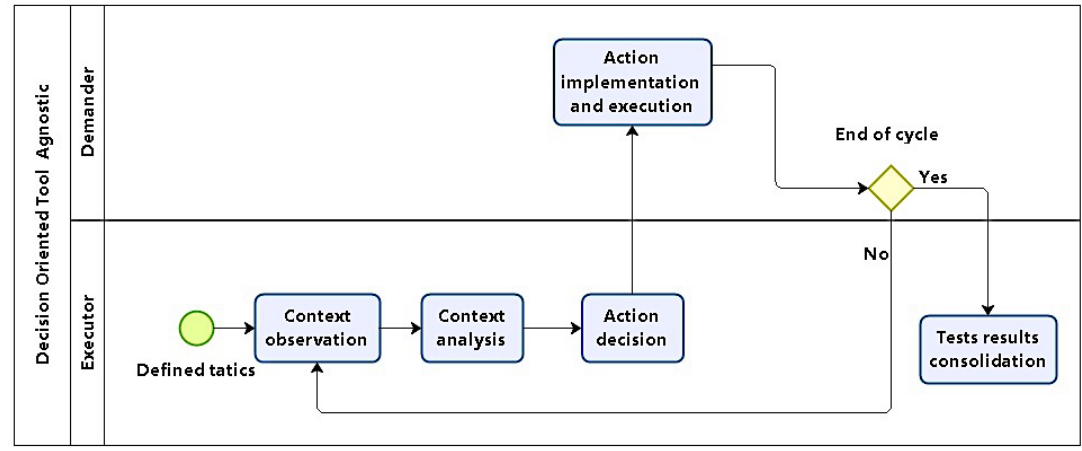
Figure 6. Phase 5: Test